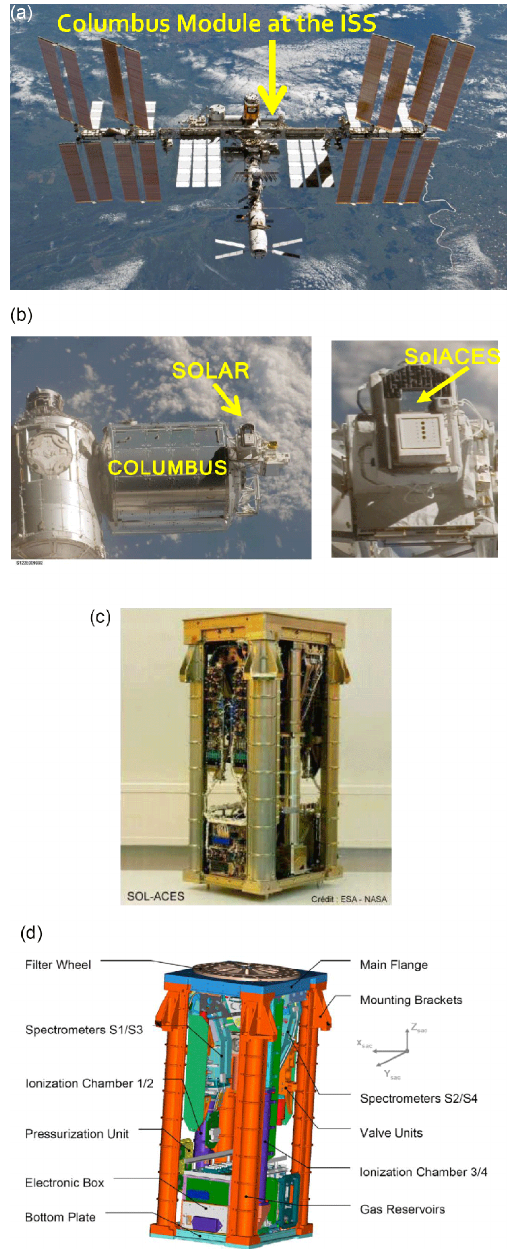
Figure 22. (a) Position of the Columbus Module at the Interna- tional Space Station (credit: ESA-NASA). (b) Position of payload SOLAR with SolACES at the Columbus Module of the ISS (credit: ESA-NASA). (c) SolACES aboard the ISS (credit: ESA-NASA). (d) SolACES includes four spectrometers and two three-current ion- ization chambers. The filter wheel with 48 apertures selects narrow intervals of the solar EUV spectrum for ionization chamber mea- surements. The gas reservoirs are structural elements of the instru- ment simultaneously (Schmidtke et al., 2006a; copyright permission granted by Elsevier